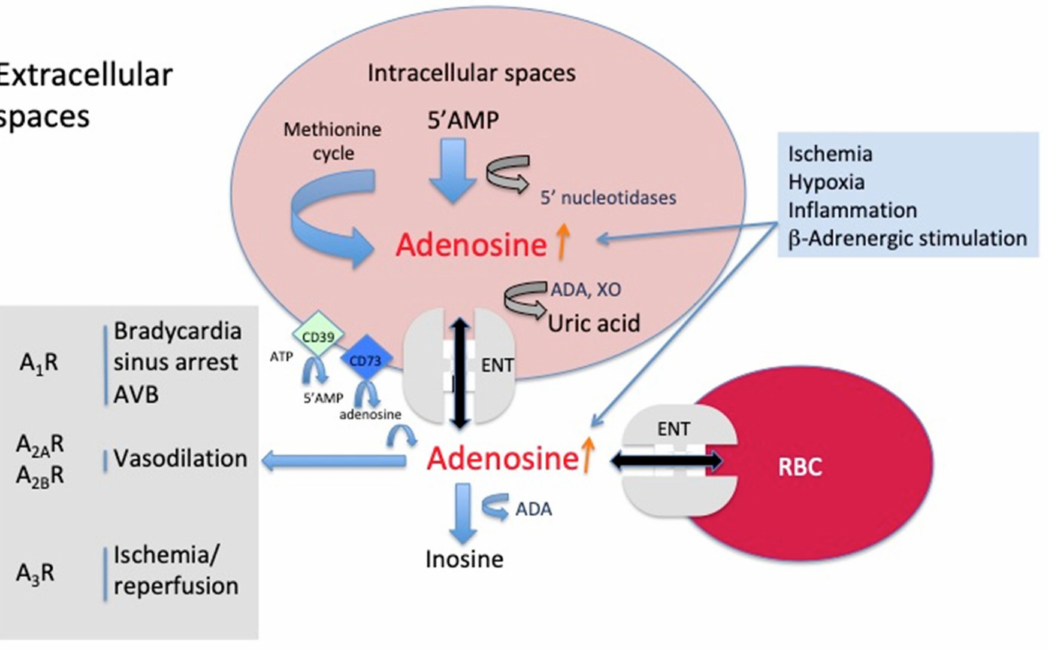
Figure 1. Representation of adenosine